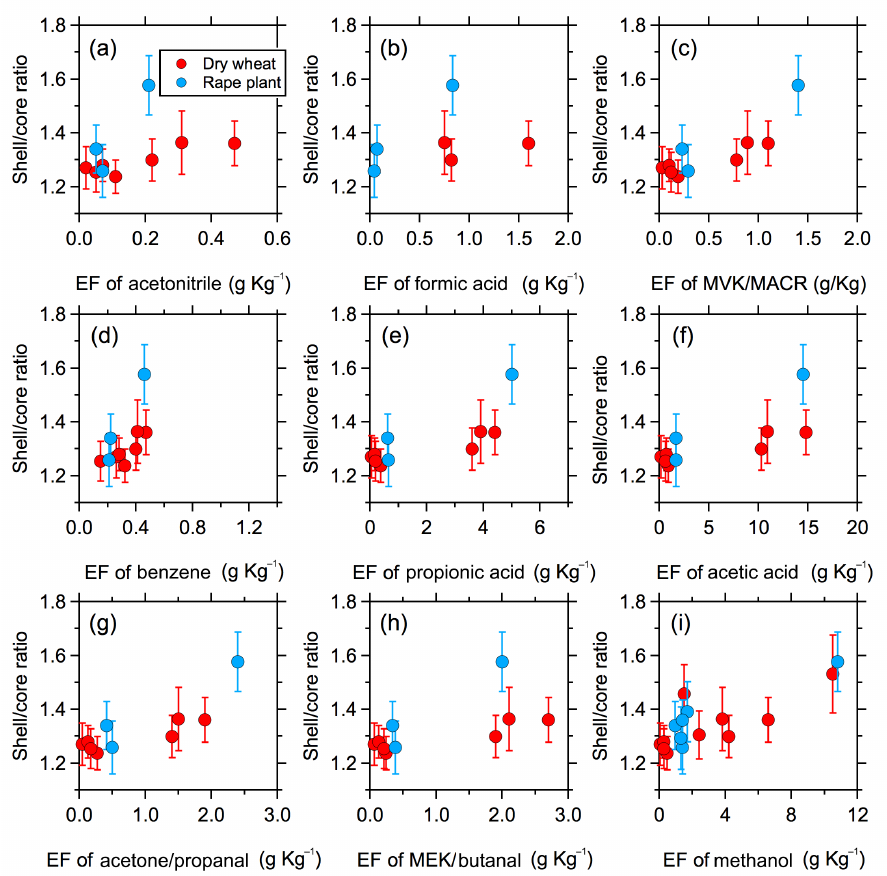
Figure 6. Variations in the shell/core ratios of rBC particles with MED = 200 ± 10nm as a function of the emission factor of each experi- ment. Here, EF is defined as the amount of each compound released per unit amount of dry fuel consumed. The red, green and blue colors indicate the dry wheat straw, wet wheat straw and rapeseed plant samples,